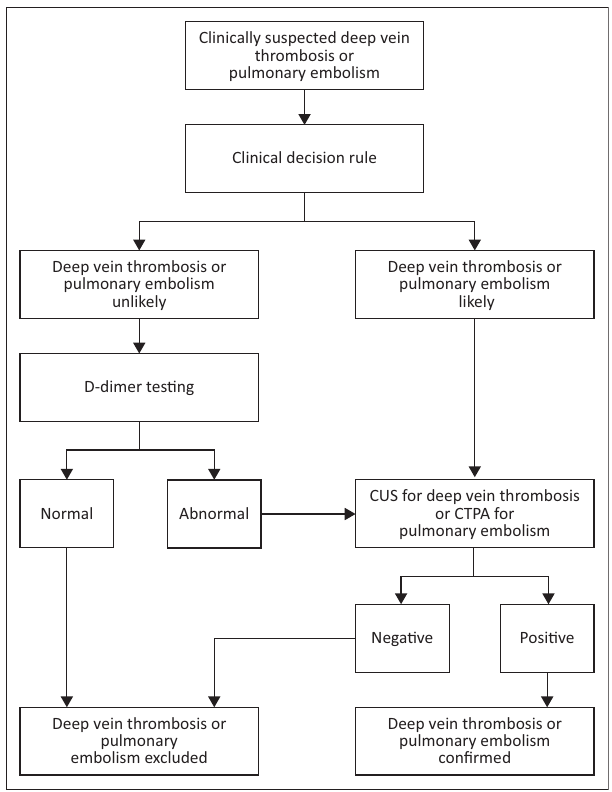
FIGURE 1-A3: Diagnostic algorithm for suspected venous thromboembolism.